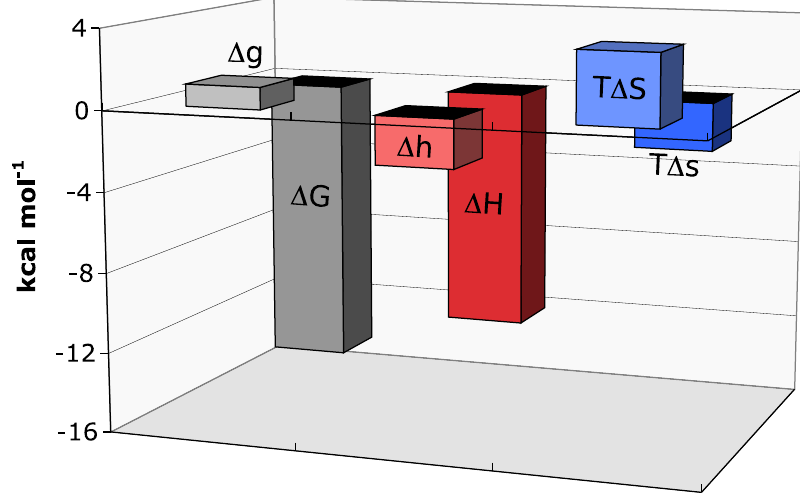
Figure 2. Global and cooperative thermodynamic parameters associated with the negatively cooperative binding of Fd to FNR-NADP +